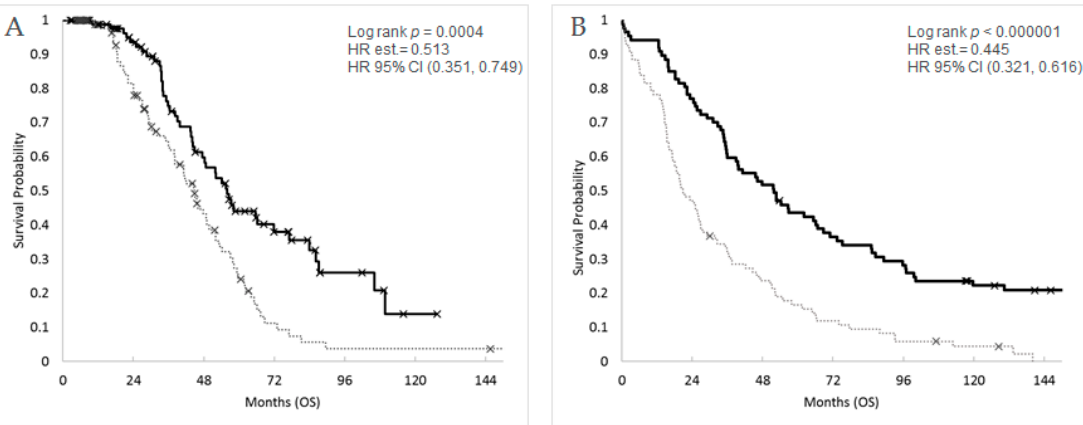
Figure 3. Kaplan–Meier plots of high (solid) vs. low (dotted) values of the T cell trafficking:M2 tumor-associated macrophages—TCT:M2TAM (ratio) signature in tumors from high-grade serous ovarian cancer (HGSOC) patients from ( A ) TCGA cohort (OS, n = 189) and ( B ) the Mayo Clinic cohort (OS, n = 174). High vs. low is determined by the median of TCT:M2TAM for the cohort. Censored overall survival (OS) times are represented by an X. HR (hazard ratio) and CI (confidence interval). Table 1. Patient characteristics for high-grade serous ovarian cancer (HGSOC) cohorts. Cohort Characteristics TCGA Cleveland Clinic-Charité Cohort